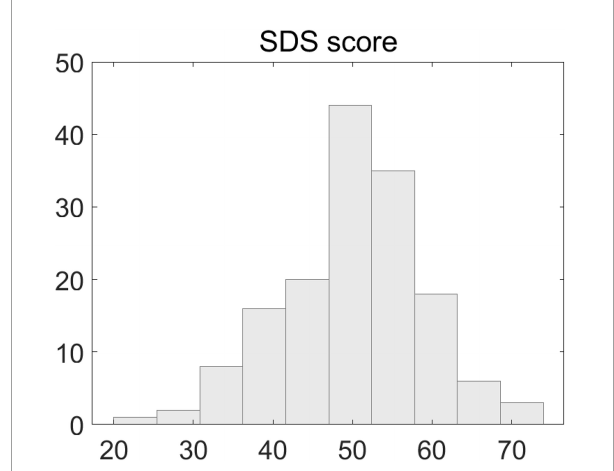
FIGURE1 Illustration of scores of Self-Rating Depression Scales. Shown is the histogram distribution of individual patients’ SDS